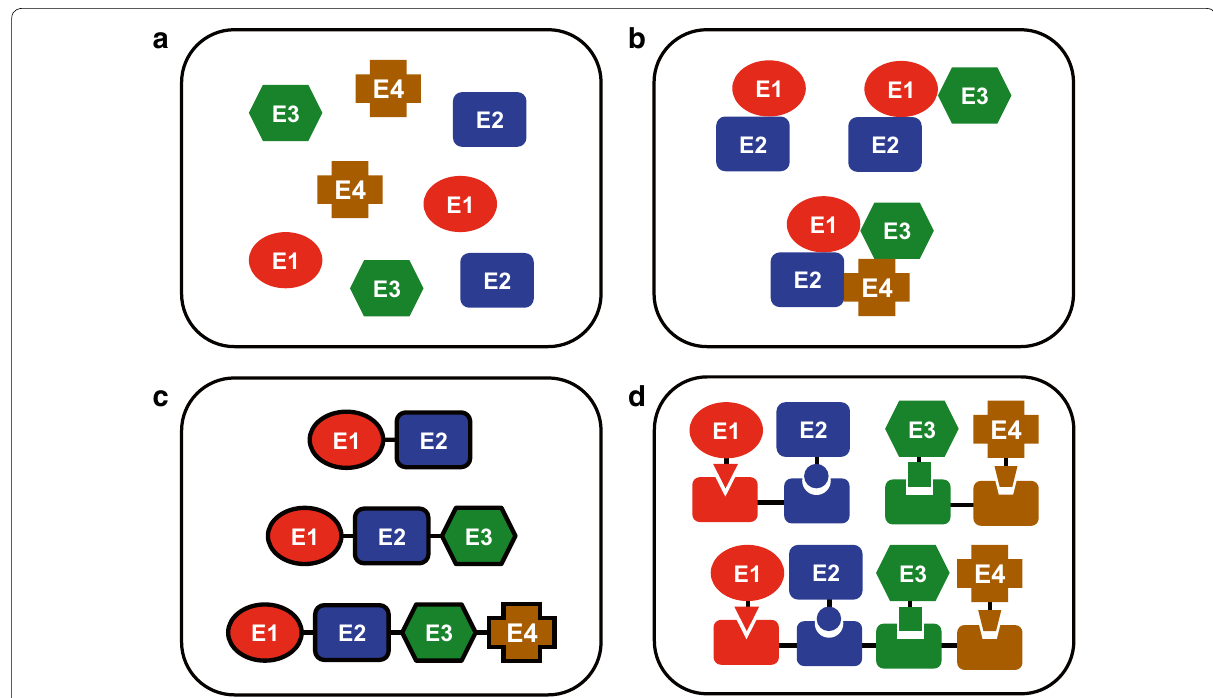
Fig. 10 Illustration of different modes of organizing enzyme complexes. a Free enzymes, b metabolon (enzyme clusters), c fusion enzymes, d scaf- folded